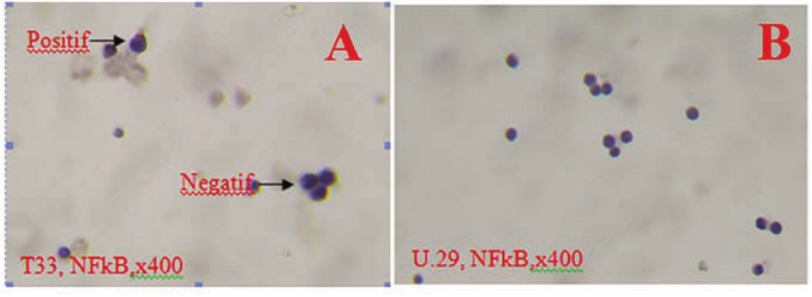
Figure 1. Immunocytochemical features from HBO treataed samples, blue and brown cell images are living cells that express the NF blue colored cells that do not express the NF